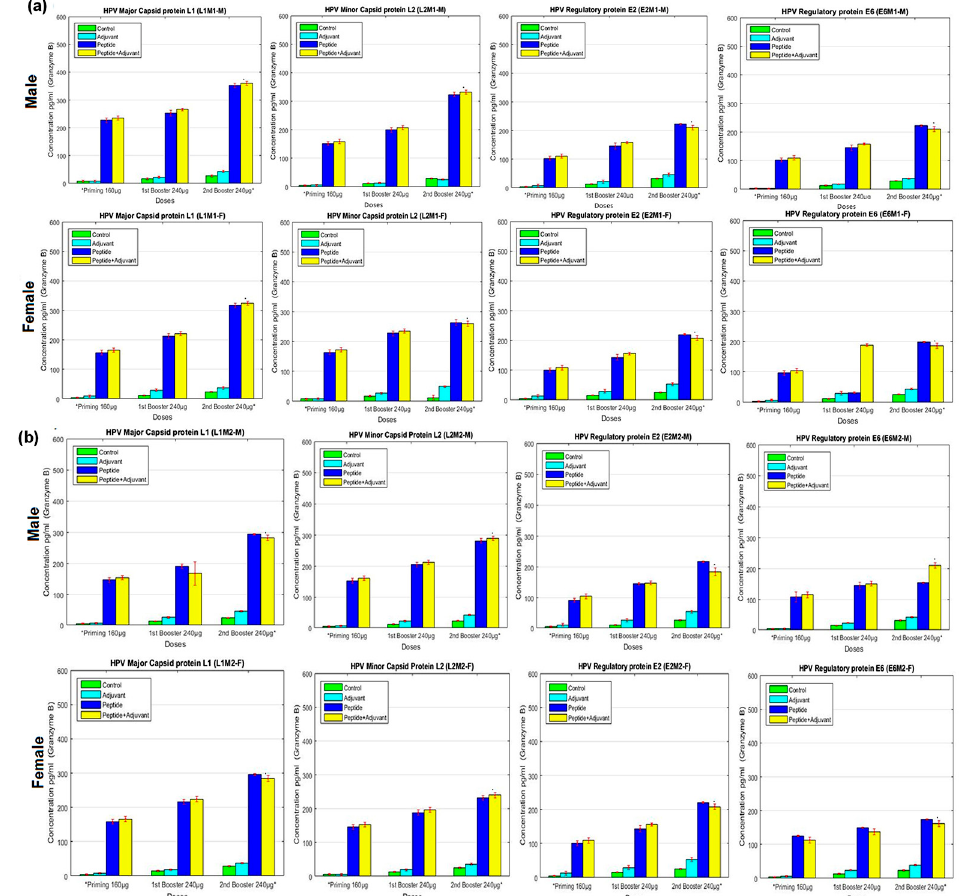
Figure 6. Granzyme B analysis of ( a ) MHC Class-I ( b ) MHC Class-II antigenic peptides measured by ELISA assays. Blood samples of experimental male and female rats immunized with potential epitopes (individual peptides) emulsified with and without adjuvant at primary, first and second booster doses. The titer rate of Granzyme B is given in pg/mL. All data were compared to control group. Bars represent ‘mean; which is signified (*) with p -value (<0.01) and standard deviation (SD).